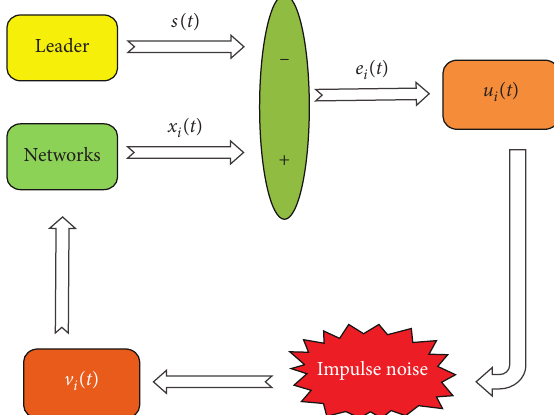
Figure 1: The synchronization framework with impulse noise